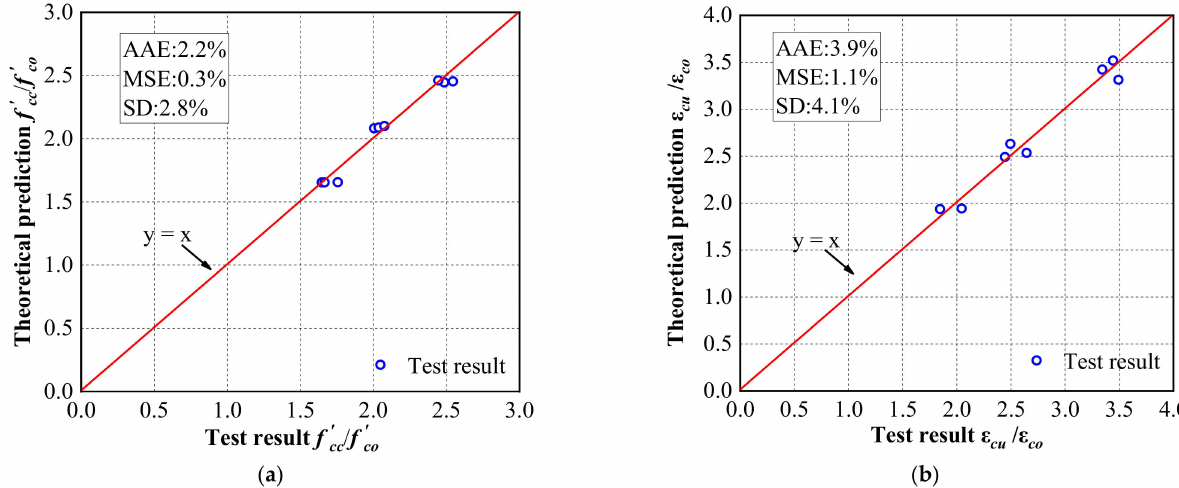
Figure 15. Comparing the predicted ( a ) ultimate axial stress and ( b ) ultimate axial strain with the test results.